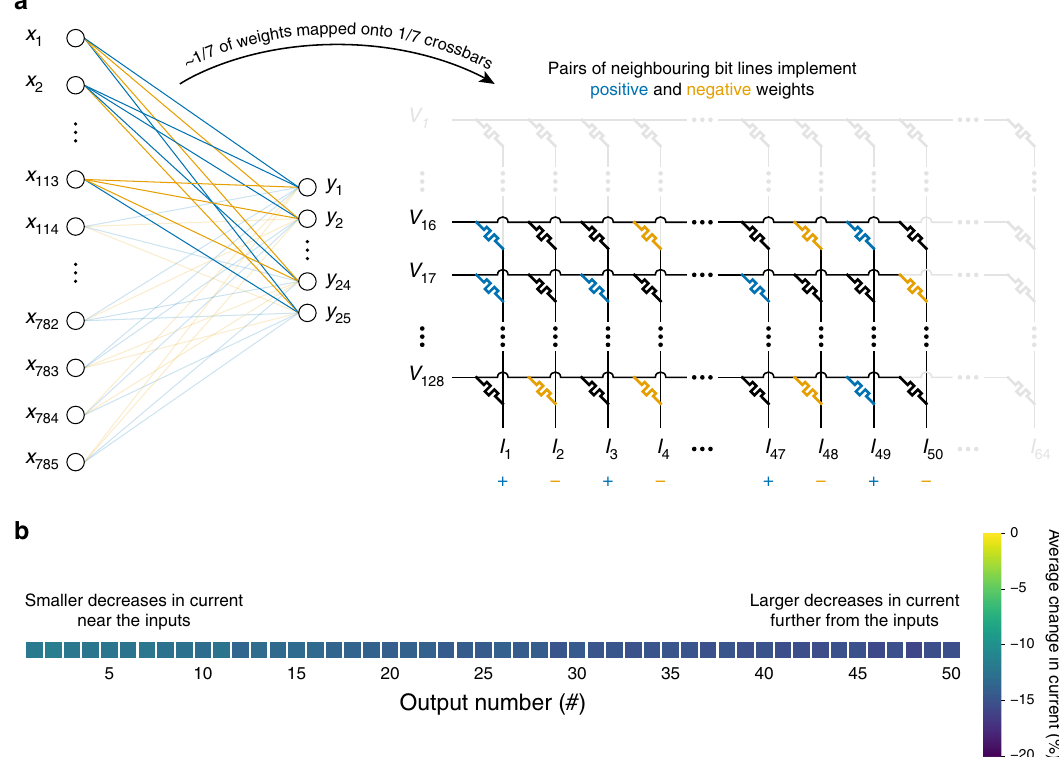
Fig. 3 Theoretical implementation of a synaptic layer using crossbar arrays. It was assumed that a synaptic layer of shape 785 × 25 would be implemented using seven crossbars of shape 128 × 64. a Mapping the fi rst subset of weights onto one of the seven crossbars. Positive weights and negative weights are mapped onto memristors in different bit lines. b Heatmap of average changes in output currents due to line resistance (in all seven Ta/HfO 2 crossbars). For this particular simulation, it was assumed that Ta/HfO 2 devices can be programmed perfectly.